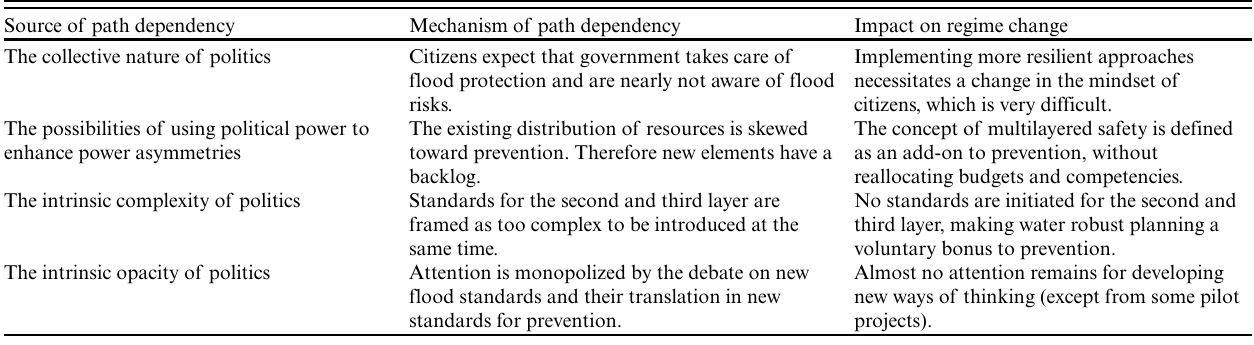
Table 4 . Mechanisms of path